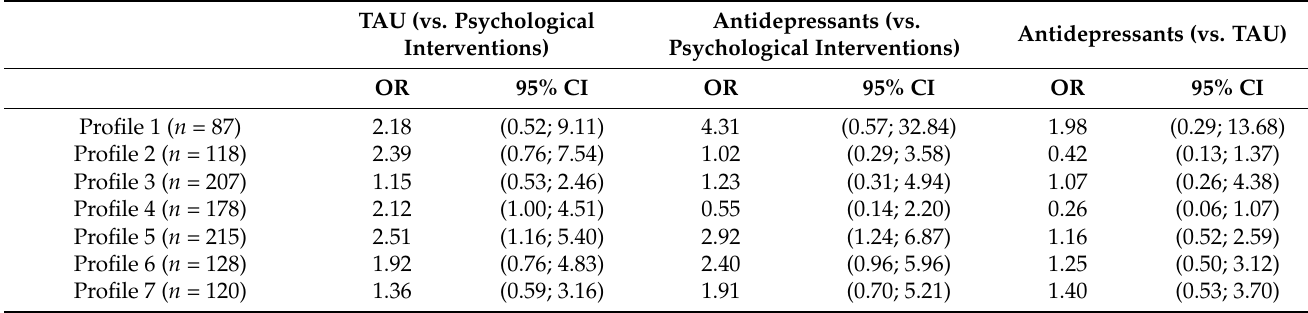
Table 6. Association between treatment types and relapse within each profile. TAU (vs. Psychological Antidepressants (vs. Antidepressants (vs. TAU) Interventions) Psychological Interventions)